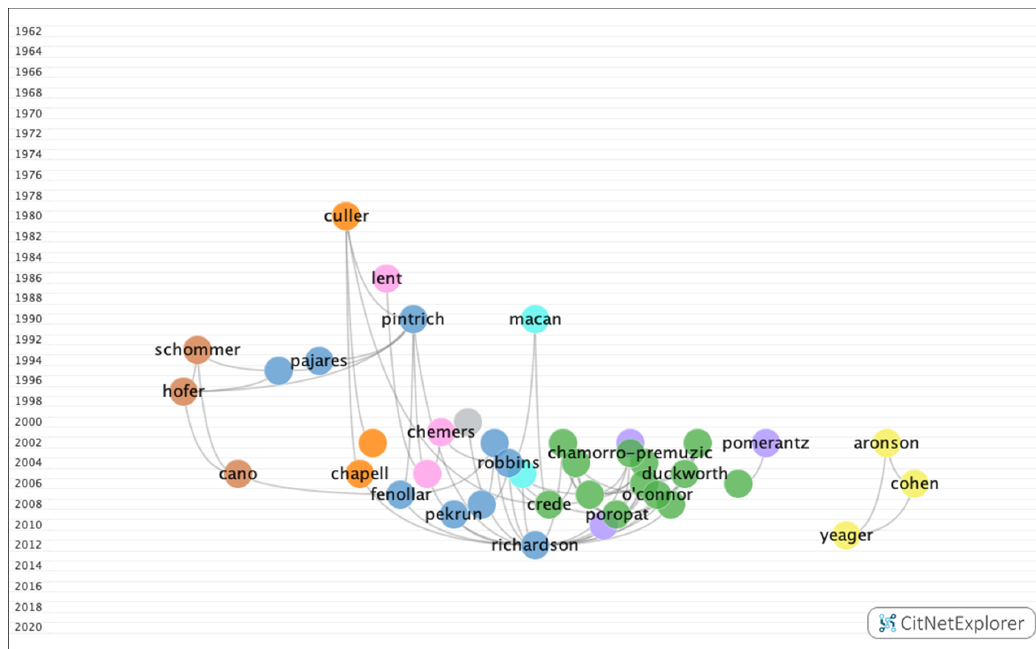
Figure 17. Group 1-subclusters citation network. Table 4. The most important subclusters from group 1.